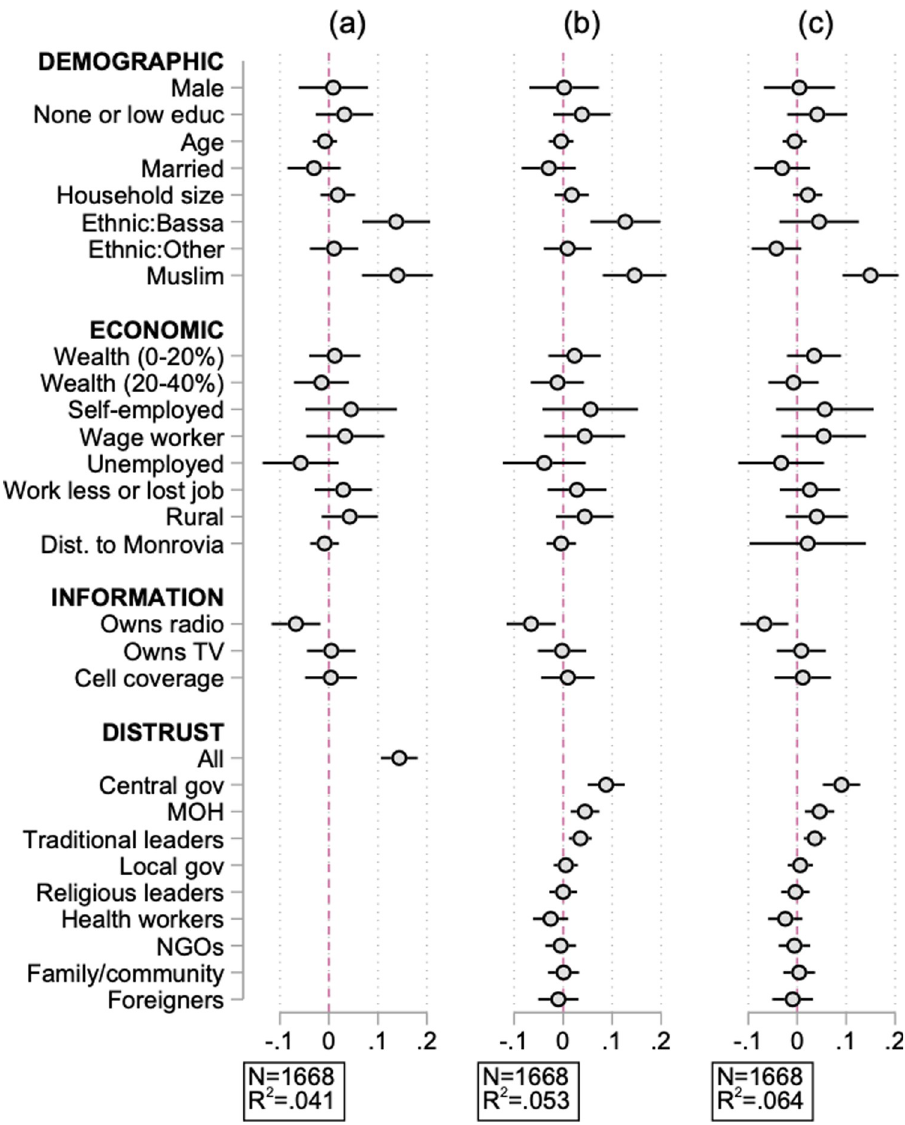
Fig 1. Profile of misinformed individuals. Dots present marginal effects from Eq 1. Spikes give 95% confidence intervals. Wealth index is constructed following the Demographic Health Surveys wealth index through a Principal Component Analysis. “Work less (2013)” equals 1 if individual worked less or lost the job since the beginning of the epidemic (in December 2013). The Distrust index is created using the − 1 × (z − score) obtained from the normalization of the reported trust for a given institution on a 1–10 scale with 10 being highest trust. “Central gov” refers to national governmental institutions: the central government, the president, the legislature. “Foreigners” refers to people outside the individual’s community or foreigners. The excluded category for Muslim is Christian and other/ no religion, which accounts for less than 4% of sample. Kpelle is the comparison category for ethnic groups. Kpelle is the majority ethnic group in Liberia. Panel (c) includes county